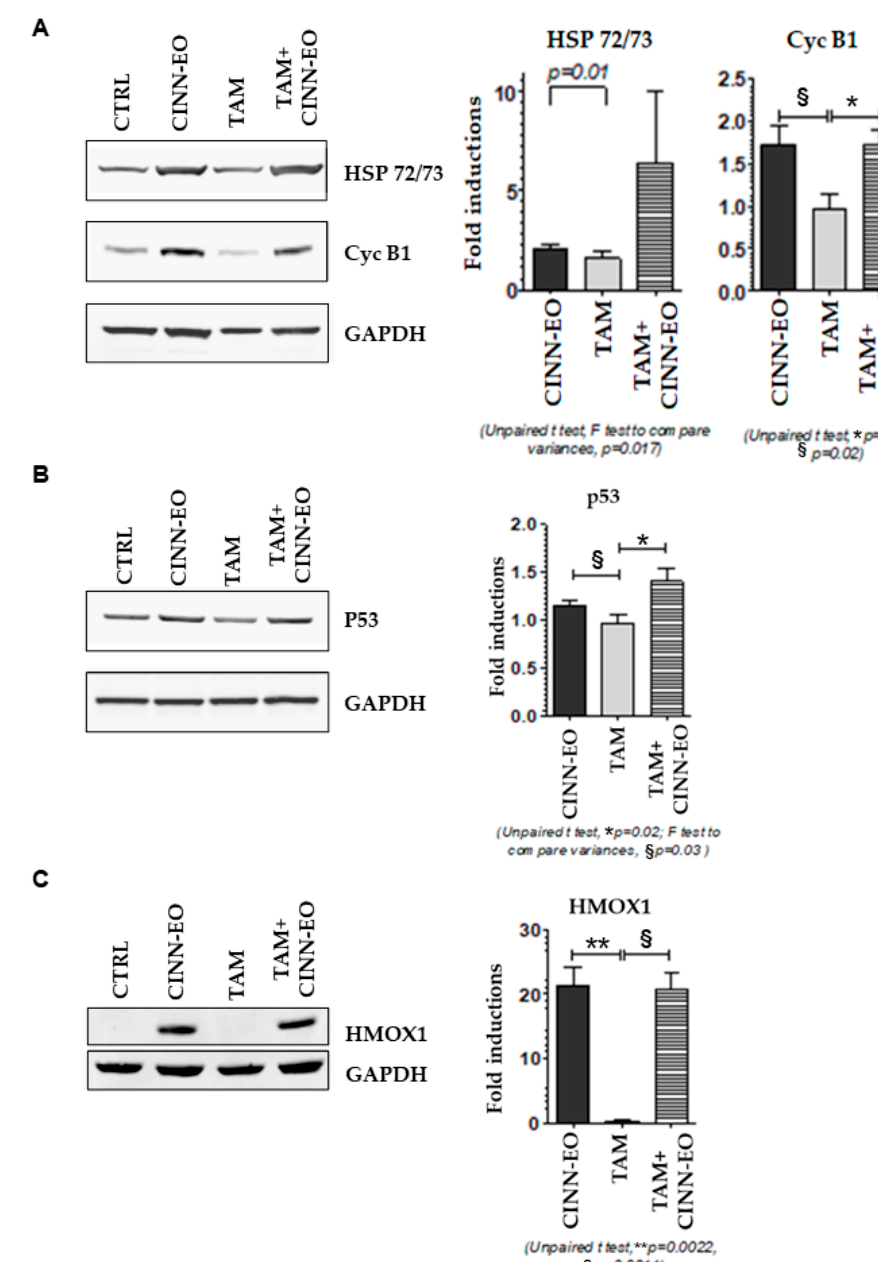
Figure 6. E ff ects of CINN-EO alone or in combination with TAM on the expression of the indicated proteins. ( A ) HSP72/73 (upper) and Cyclin B1 (middle) protein expression fold-induction vs. Ctrl (right); corresponding representative blots are shown (left). ( B ) p53 protein expression fold-induction vs. Ctrl (right) and corresponding representative blots (left). ( C ) HMOX1 protein expression fold-induction vs. Ctrl (right) and corresponding representative blots (left). GAPDH expression was used as a protein loading control in each blot. Fold-inductions are calculated for each protein versus the untreated CTRL.